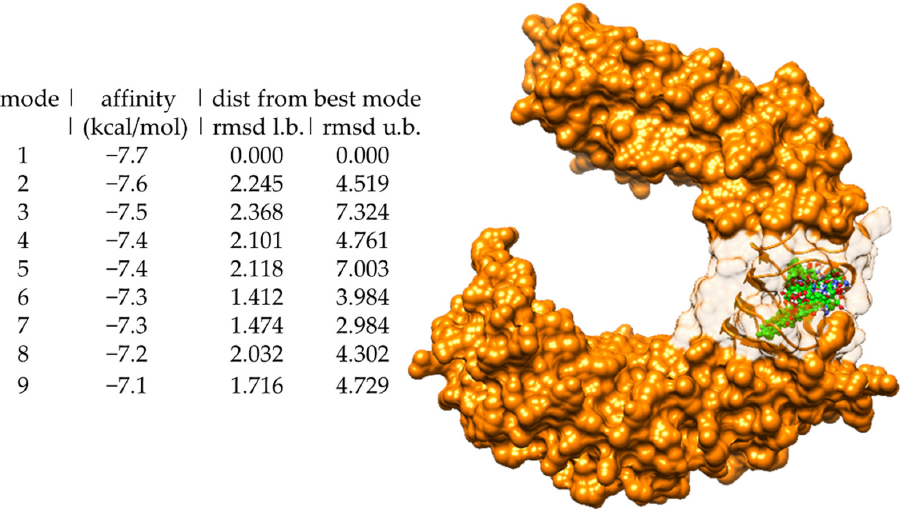
Figure 1. Binding affinities of nine best poses of LTA ( left ) and all nine conformations superimposed in the binding site of TLR2 ( right ).